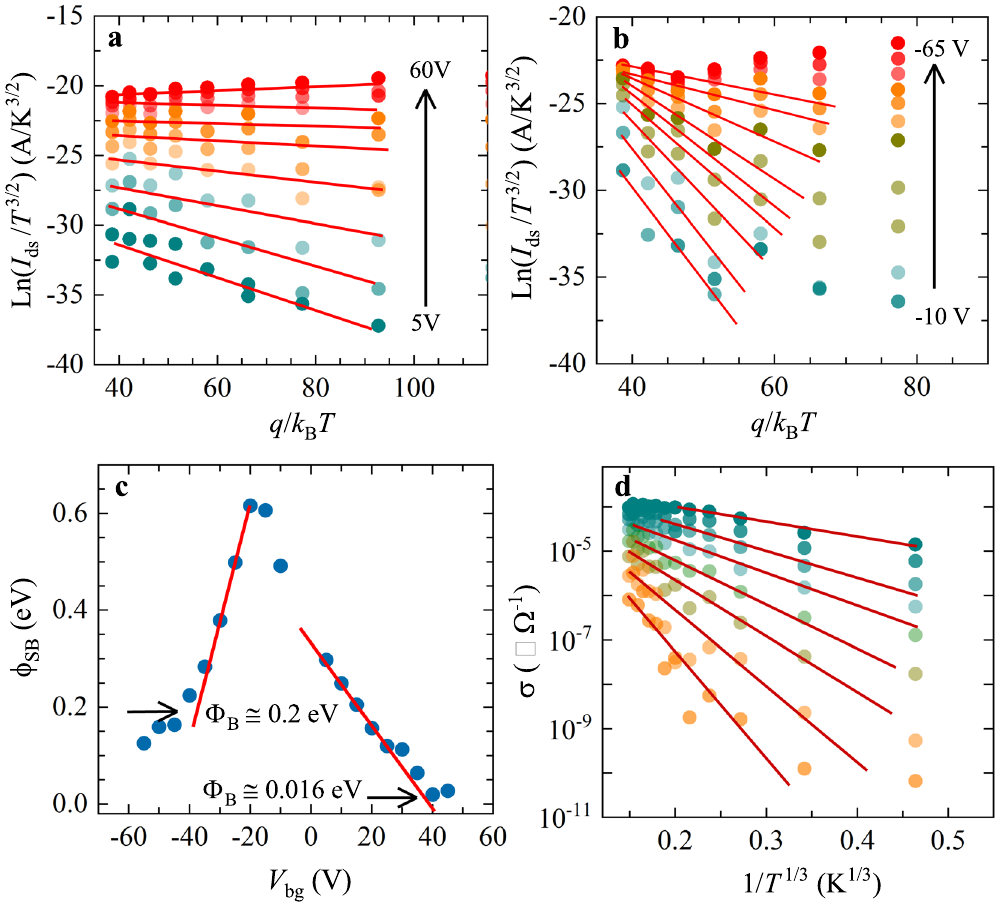
Figure 4. ( a) Drain to source current I ds normalized by a power of the temperature T as a function of the charge q = e for the n = 10 layers sample and for several positive values of the back gate voltage V bg . ( b ) Same as in ( a ) but for negative values of V bg . Both data sets in (a) and in (b) were measured under V ds = 50 mV. In both panels red lines are linear fits from which we extracted the gate voltage dependence of the Schottky barrier φ SB ( V bg ) between metallic contacts and the semiconducting channel. ( c ) φ SB as a function of V bg , showing that in the limit of high gate voltages (flat band condition), the extracted Shottky barriers Φ B were ~200 meV for holes and ~16 meV for electrons respectively. ( d ) Conductivity σ = I ds / V ds l / w , where l and w are length and width of the semiconducting channel respectively, as a function of 1/ T 1/3 and for several gate voltages. Dark red lines are linear fits indicating that at lower temperatures the conductivity as a function of T can be described by the two- dimensional variable range hopping